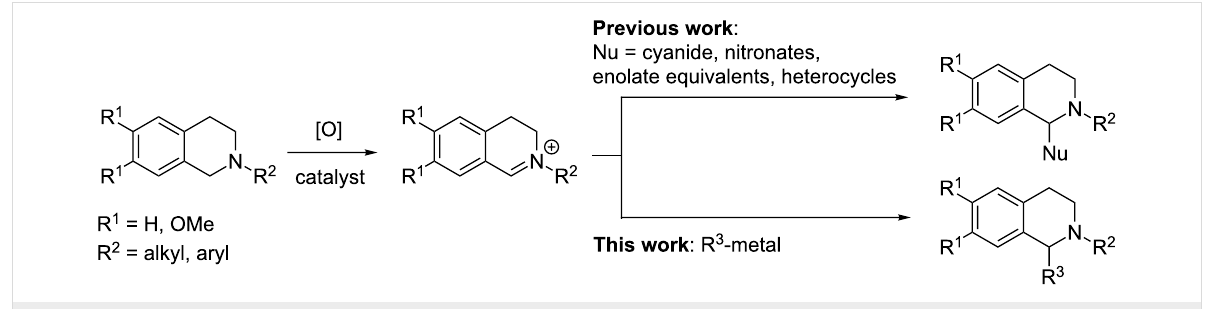
Scheme 1: Oxidative C–H functionalisation and examples of previously reported nucleophilic